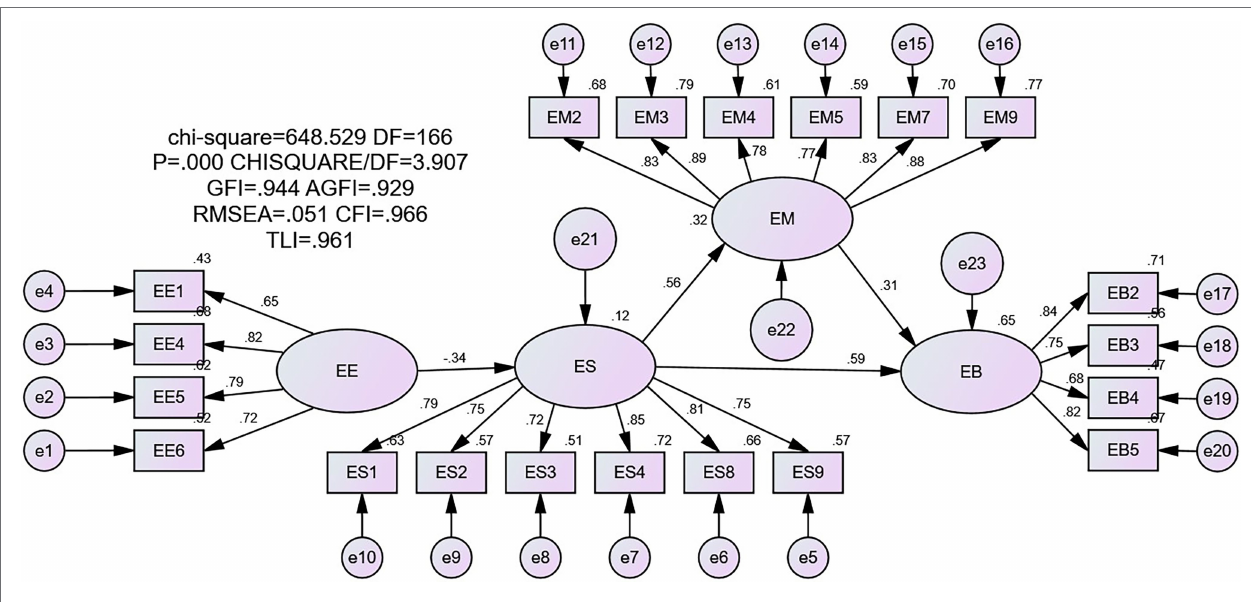
FIGURE 2 | Research framework model.